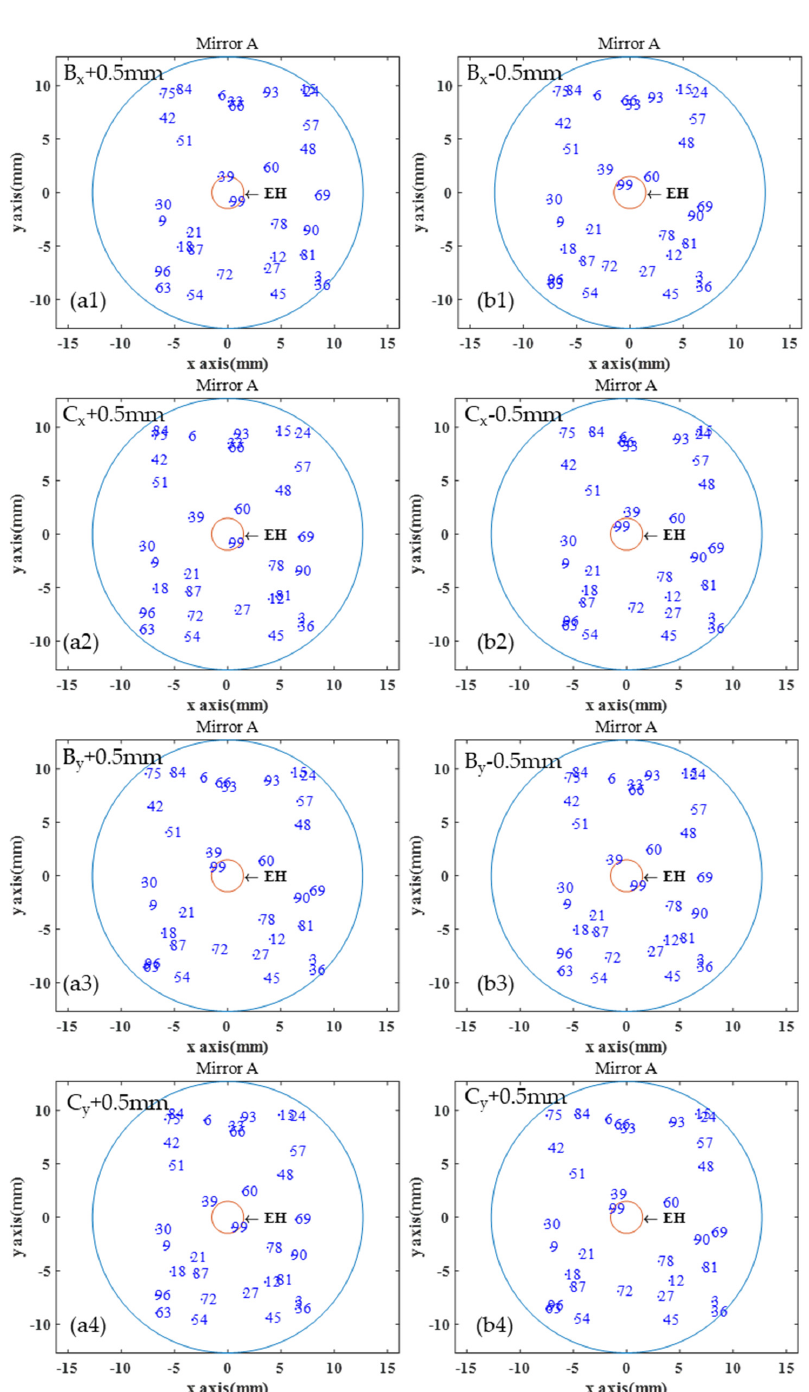
Figure 3. The simulated reflection number and spot distribution on mirror A with ( a1 ) Bx + 0.5 mm, ( b1 ) Bx − 0.5 mm, ( a2 ) Cx + 0.5 mm, ( b2 ) Cx − 0.5 mm, ( a3 ) By + 0.5 mm, ( b3 ) By − 0.5 mm, ( a4 ) Cy + 0.5 mm, ( b4 ) Cy − 0.5 mm.